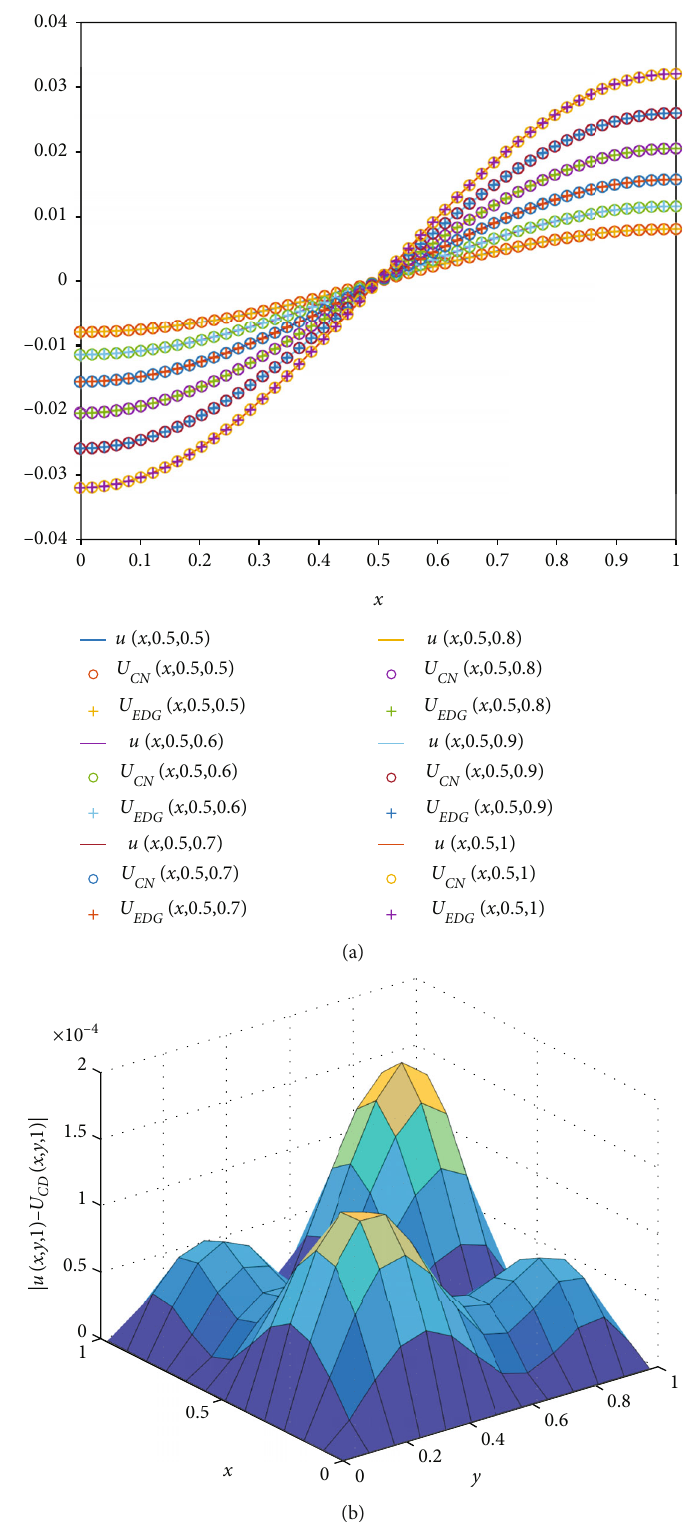
Figure 6: The exact, Crank – Nicolson, and EDG solutions in di ff erent values of t (a) and the absolute error of Crank – Nicolson method at T = 1 (b) of Example 16 for Δ t = 0 : 01 , Re = 10 , N = 49 , and α = 0 : 5